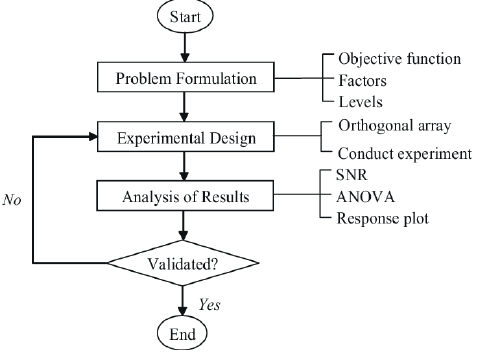
Figure 2. Flow diagram of the Taguchi method.